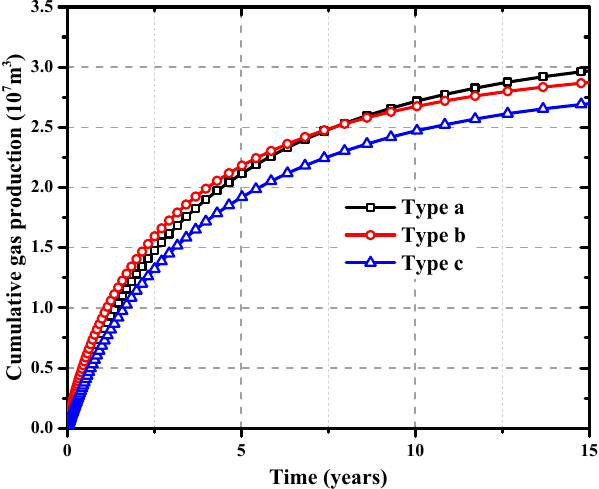
Figure 4. Cumulative gas production from a fractured reservoir with three fractal discrete fracture networks.